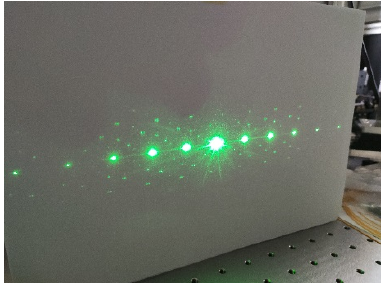
Fig. 6. Interference pattern obtained with created diffraction grating in the free-standing PMMA film. Table 1. Intensity of fringes in the interference patterns obtained with the created diffraction gratings. Fringe